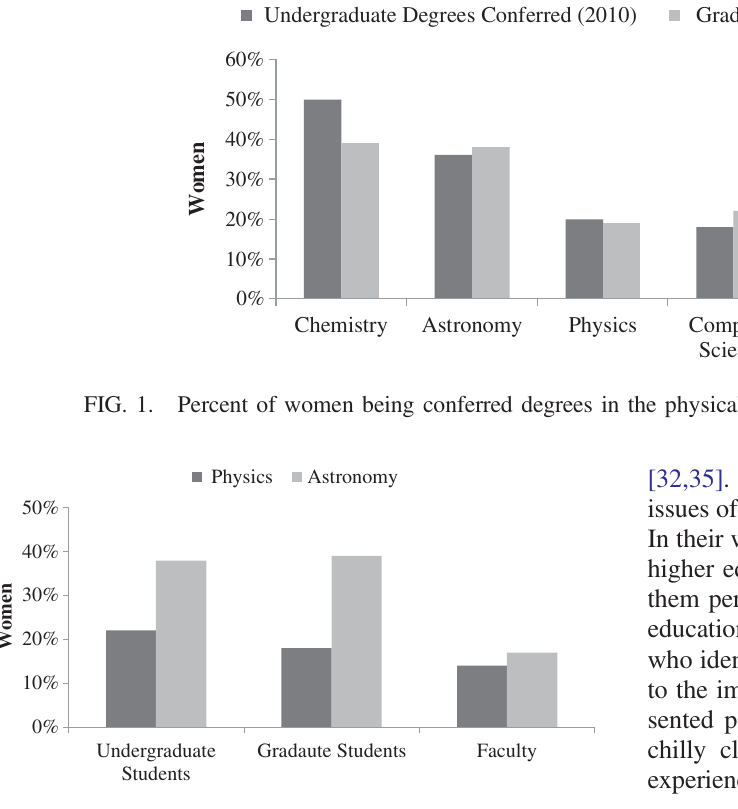
FIG. 2. Percent of women at various stages of physics and astronomy educational pathways at the time of the interviews